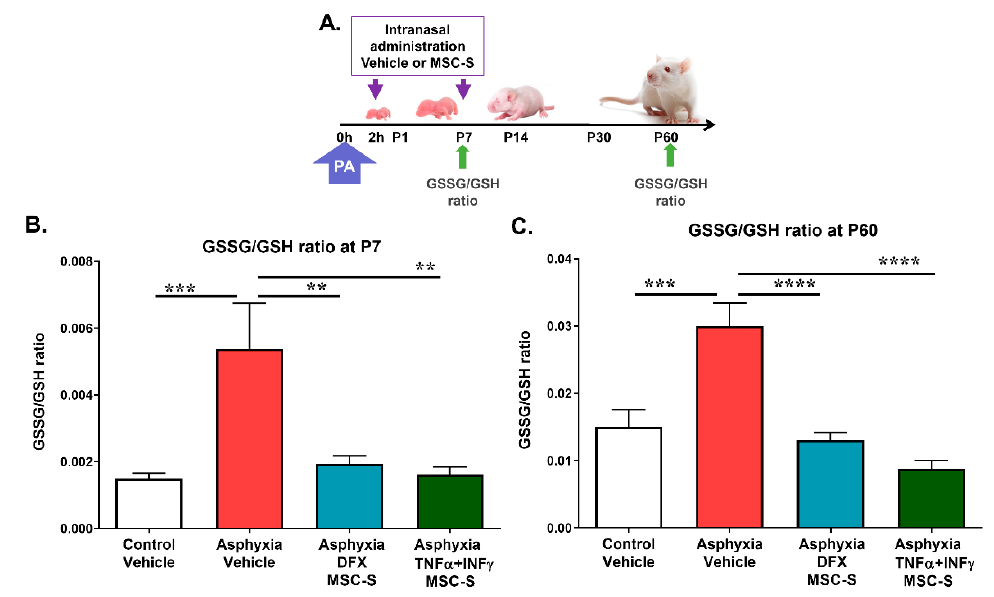
Figure 1. E ff ect of intranasal administration of DFX- or TNF- α + IFN- γ -MSC-S on hippocampal oxidative stress (GSSG / GSH ratio) induced by PA evaluated at P7 and P60. ( A ). Schematic representation of intranasal administration of vehicle or MSC-S monitoring schedules. Animals evaluated at P7 received only one MSC-S dose (2 h after birth), and those evaluated at P60 received two doses (2 h after birth and at P7). The GSSG / GSH ratio was determined in the hippocampus of control and asphyxia-exposed rats (intranasally treated with vehicle or either DFX- or TNF- α + IFN- γ -MSC-S, evaluated at P7 and P60. ( B ). GSSG / GSH ratio at P7: PA-exposed rats treated with vehicle (AS) (red bar) showed an increased GSSG / GSH ratio, versus vehicle-treated (CS) controls (white bar). Administration of a single dose of DFX-MSC-S (cyan bar) or TNF- α + IFN- γ -MSC-S (green bar) fully reversed the e ff ect of PA on the GSSG / GSH ratio. Data represent means ± SEM. One-way ANOVA, F (3,30) = 6.375, ** p < 0.005. Benjamini, Hochberg, and Yekutieli post-hoc: *** p < 0.0005; CS v / s AS, ** p < 0.005; AS v / s Asphyxia-DFX-MSC-S, ** p < 0.005; AS v / s Asphyxia-TNF- α + IFN- γ -MSC-S, N = 6–10 samples per group. ( C ). GSSG / GSH ratio at P60: AS rats (red bar) still displayed an increased GSSG / GSH ratio versus CS (white bar). Administration of two intranasal doses of DFX- (cyan bar) or TNF- α + IFN- γ -MSC-S (green bar) fully reversed the e ff ect of PA on the GSSG / GSH ratio. One-way ANOVA, F (3,16) = 18.55, **** p < 0.0001. Benjamini, Hochberg, and Yekutieli post-hoc: *** p < 0.0005, CS v / s AS, **** p < 0.0001; AS v / s Asphyxia-DFX-MSC-S, **** p < 0.0001; AS v / s Asphyxia-TNF- α + IFN- γ -MSC-S, N = 4–6 samples per group.